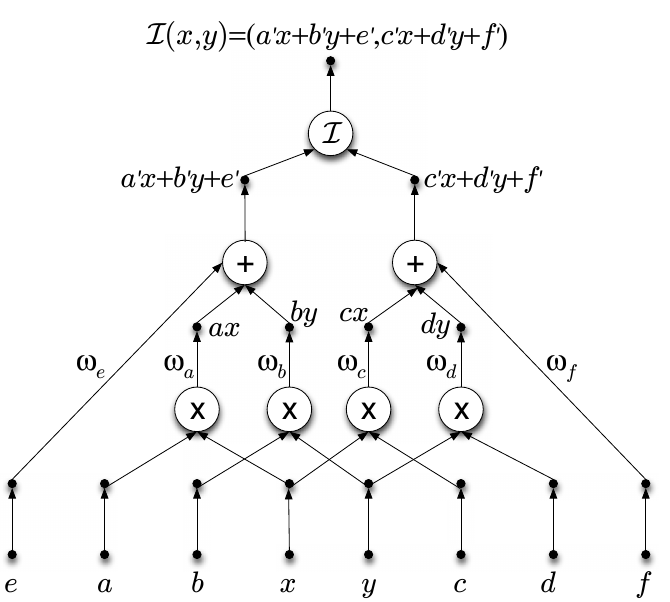
Figure 1. Functional network of the contractive affine map in Equation